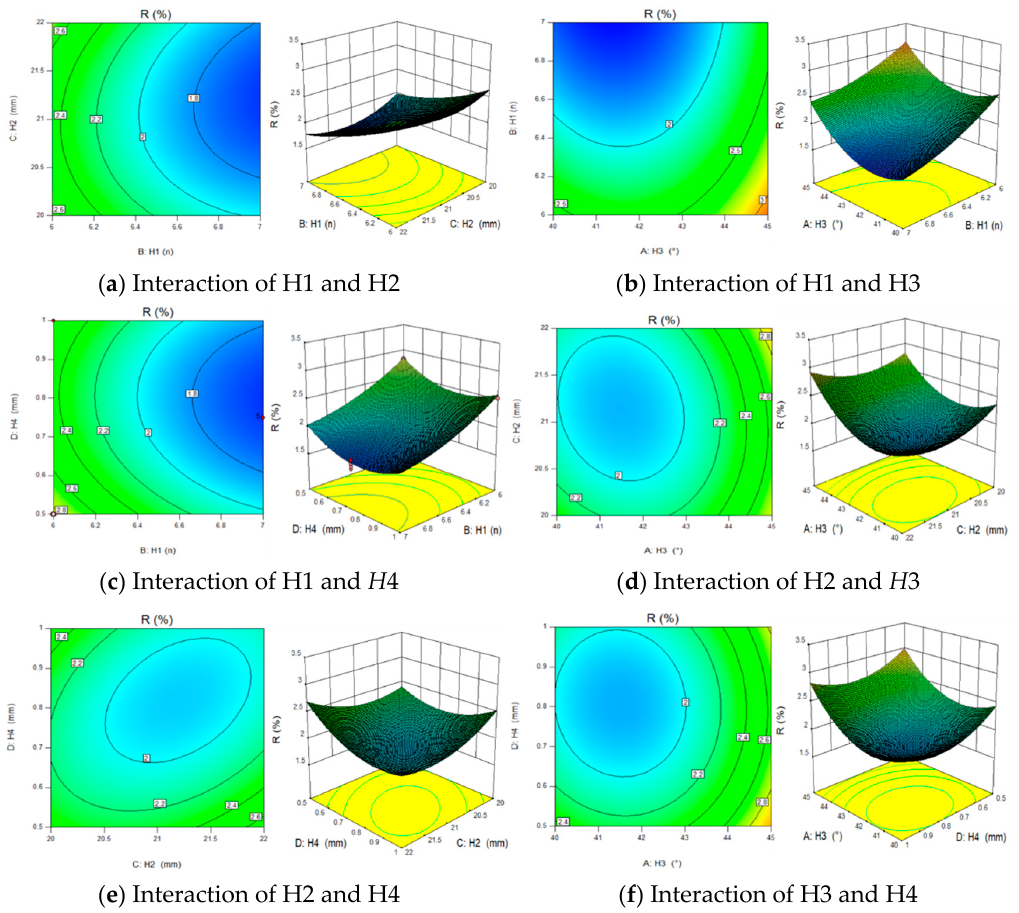
Figure 13. Four-factor interaction curve and contour map.